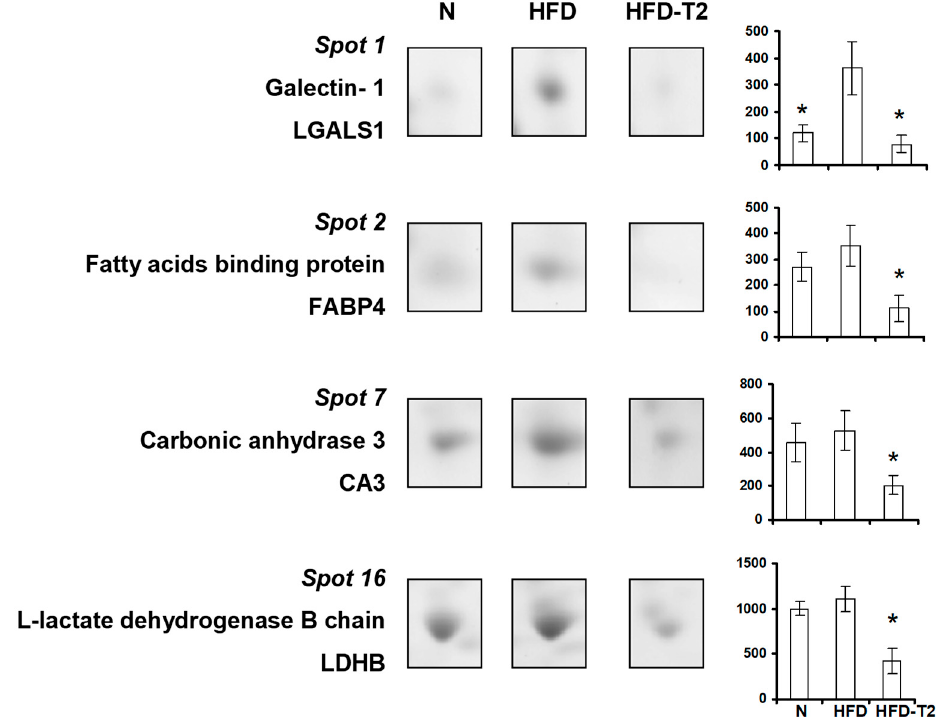
Figure 6. Four-week 3,5-T2 treatment-associated differential representation within the VAT proteome with regard to metabolically relevant proteins. Representative subsections of 2D-E images of VAT of N, HFD, HFD-T2 rats. Results are expressed as arbitrary units (means ± SEM; n = 4). * p < 0.05 vs. HFD. Spot numbering refers to Figure 5a.